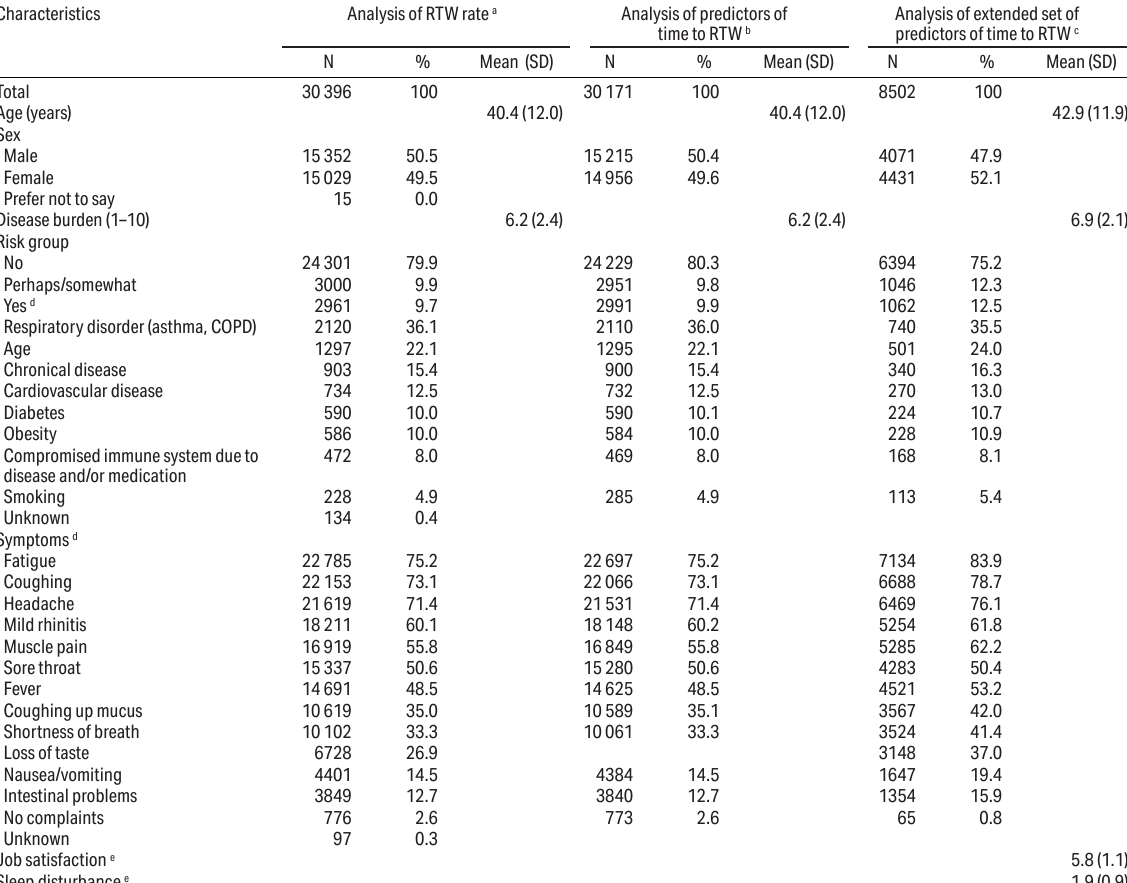
Table 1. Participant characteristics. [SD=standard deviation; COPD=chronic obstructive pulmonary disease.] Characteristics Analysis of RTW rate a Analysis of predictors of